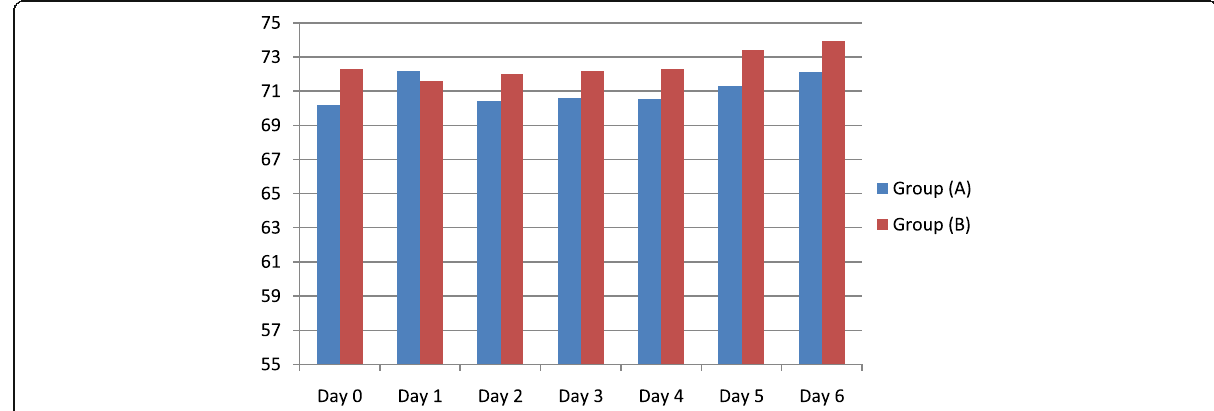
Fig. 1 Bar chart showing the comparison between group A (control) and group B (esmolol) according to MAP